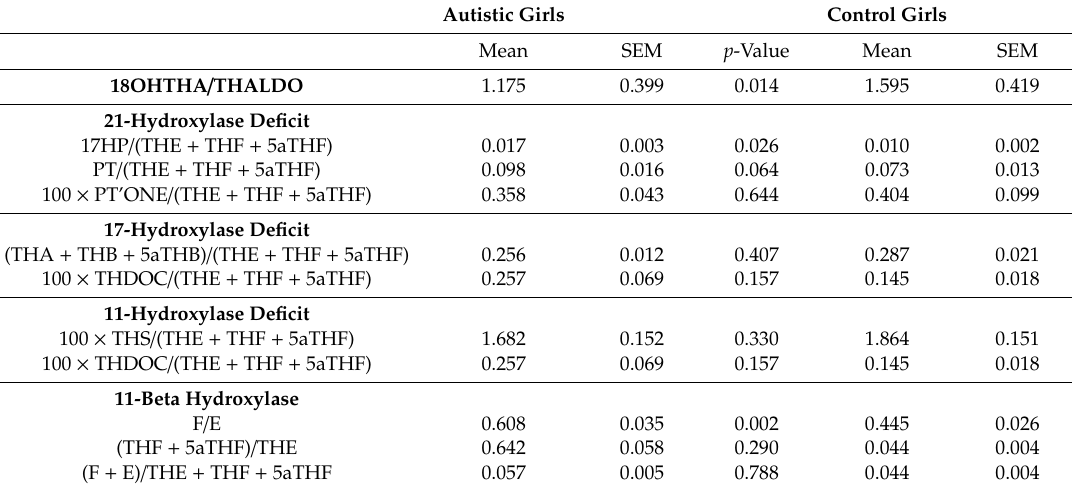
Table 2. Enzyme activities in a ff ected prepubertal autistic girls ( n = 5) and post-pubertal autistic girls ( n = 11) versus matched controls. Tetrahydroaldosterone (THADLO), 18-Hydroxy-tetrahdrocompound (18OHTHA-THALDO), Pregnanolone (HP), 17-Hydroxypregnanolon (17-HP), TetrahydroDOC (THDOC), Tetrahydrodehydro-corticosterone (THA), Tetrahydrocorticosterone (THB), 5a- Tetrahydrocorticosterone (5a-THB), 5a-Tetrahydrocortisol (5a-THF), Tetrahydrosubstance S (THS), 11-Oxo-Pregnanetriol (PT’ONE), Tetrahydrocortisone (THE), Tetrahydrocortisol (THF), 5a-Tetrahydrocortisol (5a-THF). Autistic Girls Control Girls Mean SEM p -Value Mean